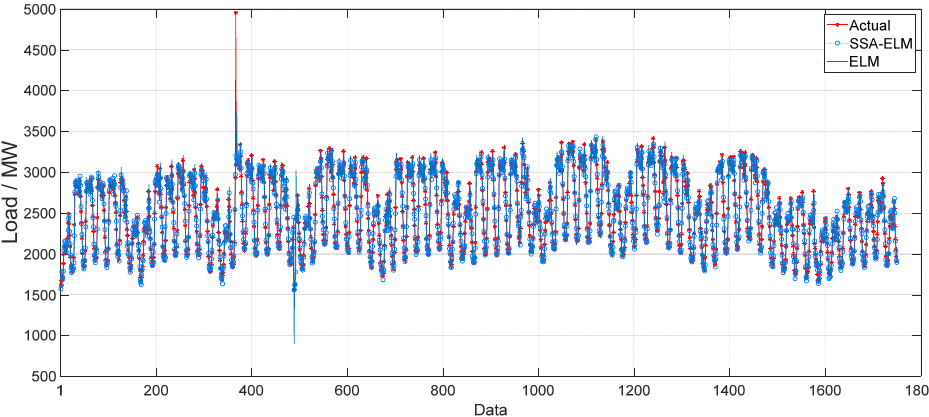
Figure 3. Comparison of actual and predicted values.